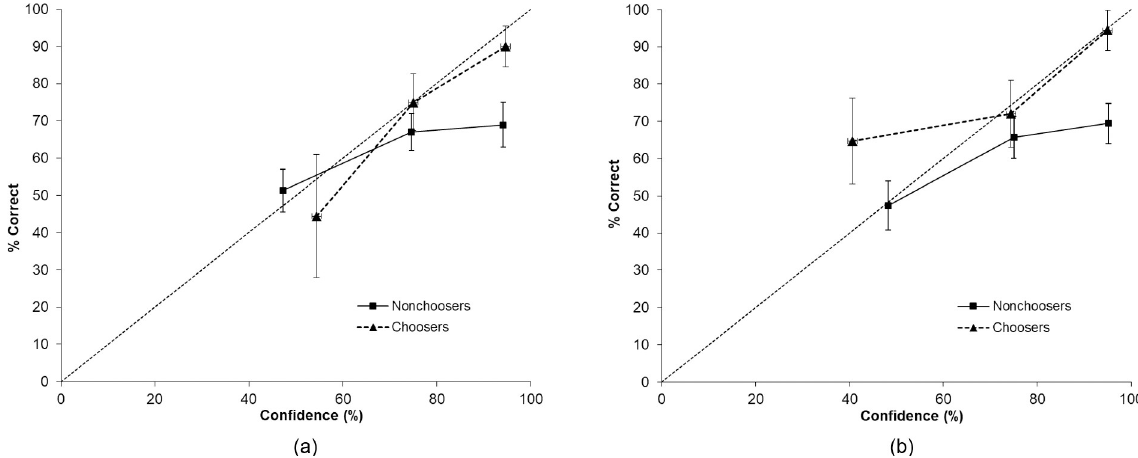
Fig 1. Eyewitnesses’ (a) and Lineup Administrators’ (b) Post-Decision Confidence-Identification Accuracy Calibration Curves split for Choosers and Nonchoosers (and Standard Error).